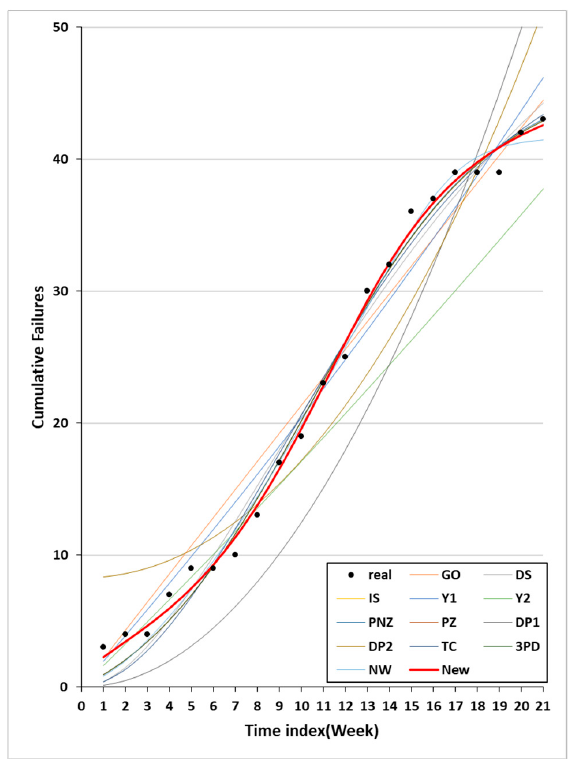
Figure 4. Actual data and estimated mean value function for Dataset #3.